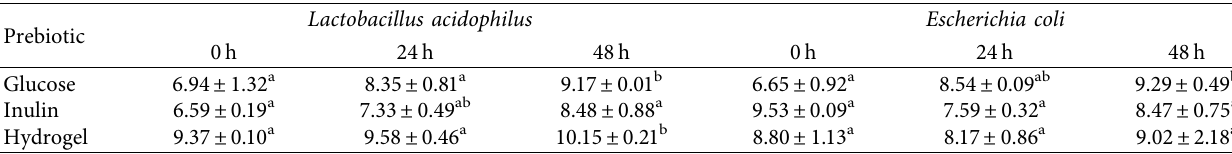
Table 4: Density of Lactobacillus acidophilus FNCC 0051 and Escherichia coli cells in 10 log CFU/mL after 0 h, 24h, and 48 h of incubation with prebiotics, inulin, hydrogel, and glucose.